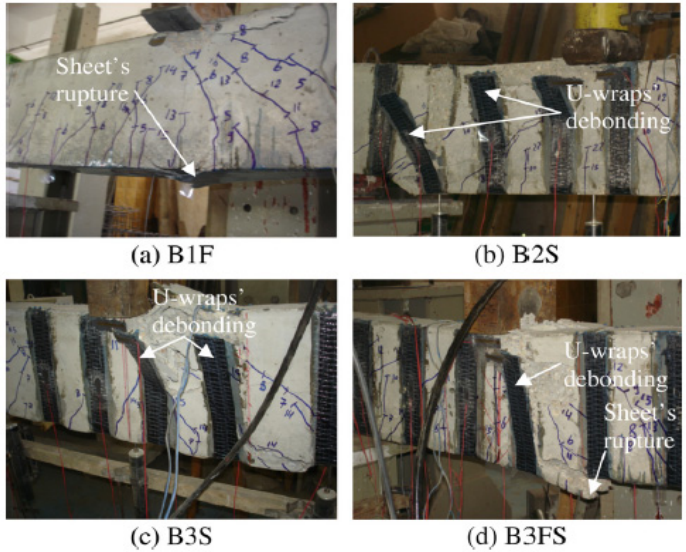
Figure 8. Failure modes experienced [59].